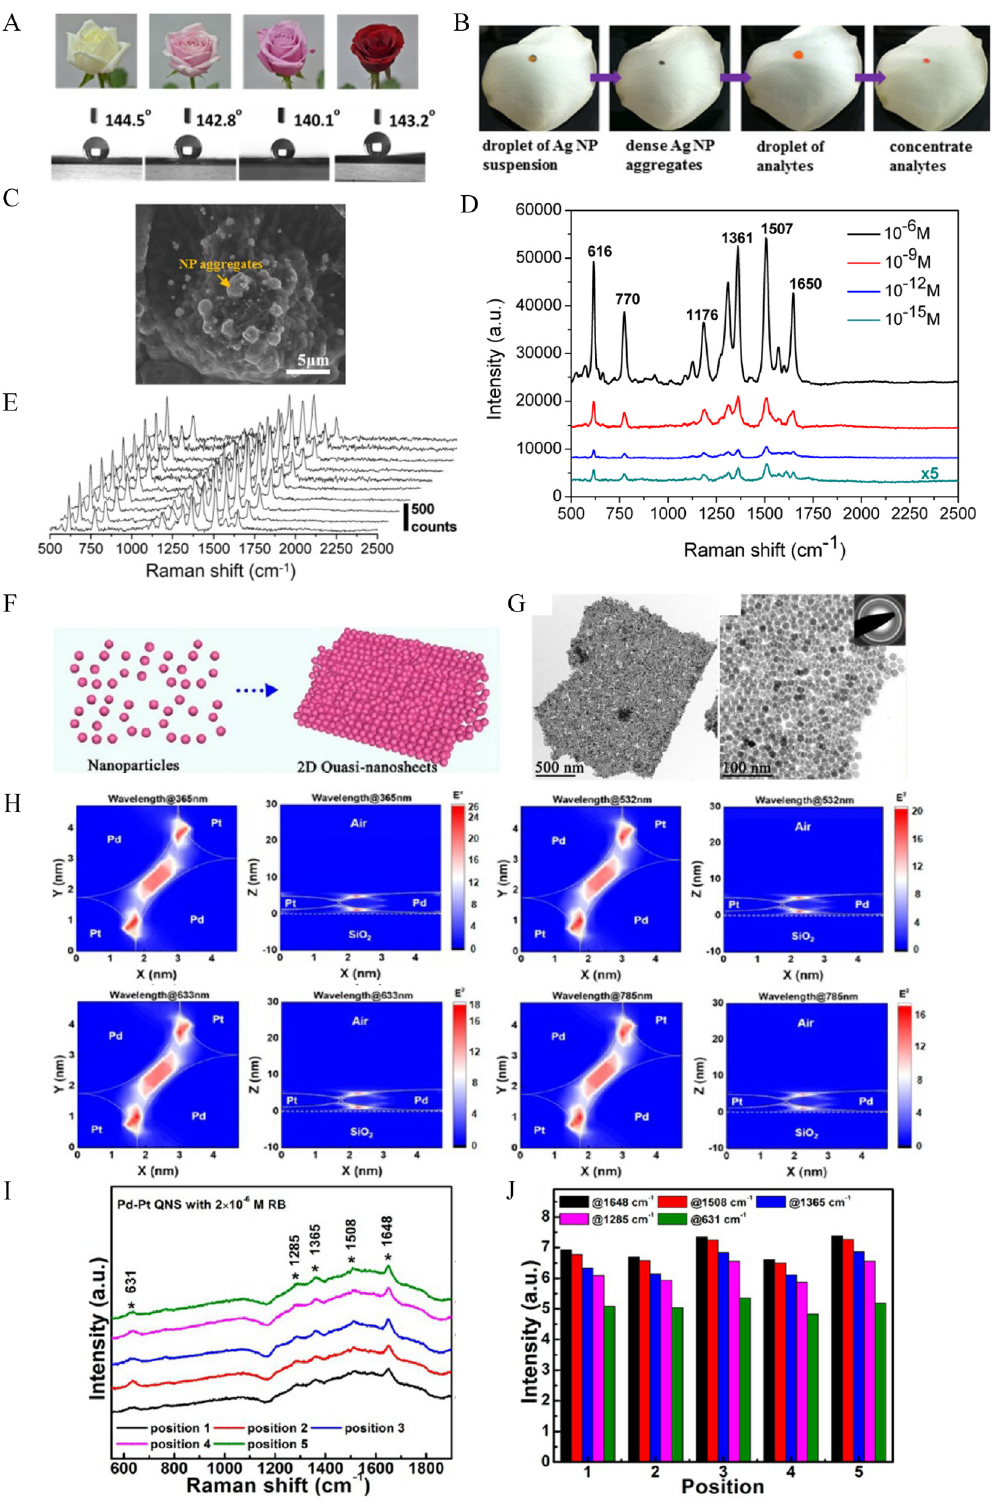
Figure 2: (A) Surface wetting property of white, pink, deep pink, and red rose petals. (B) Photographs of the process flow of Ag NPs and analytes on a white rose petal. (C) SEM image of the aggregated Ag NPs with concentrated the analytes on surface of rose petal. (D) Measured concentration-dependentRamanspectraofrosepetal-basedSERSsubstrates.(E)ReproducibilityoftheRamanspectraof10 − 12 Manalyteat10 different positions on the rose petal-based SERS substrates [79]. Copyright 2015, American Chemical Society. (F) Schematic